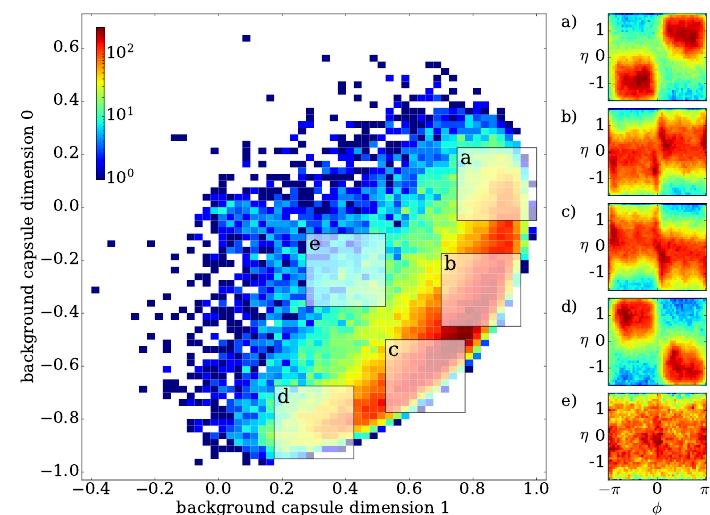
Figure 11: Distribution of the two entries in the 2-dimensional background capsule for background events. Right: average event images in the η − φ plane.